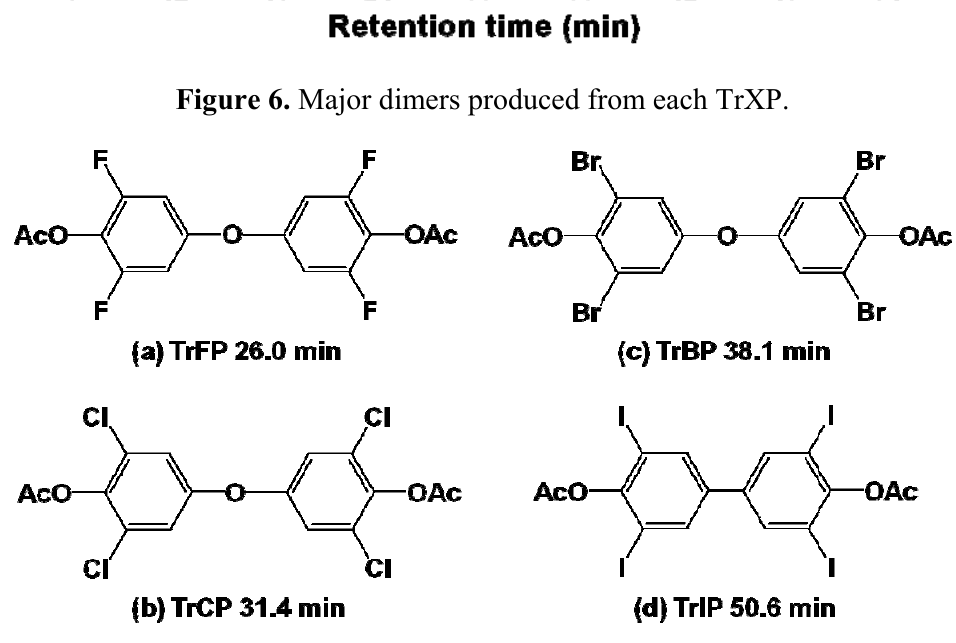
Figure 6. Major dimers produced from each